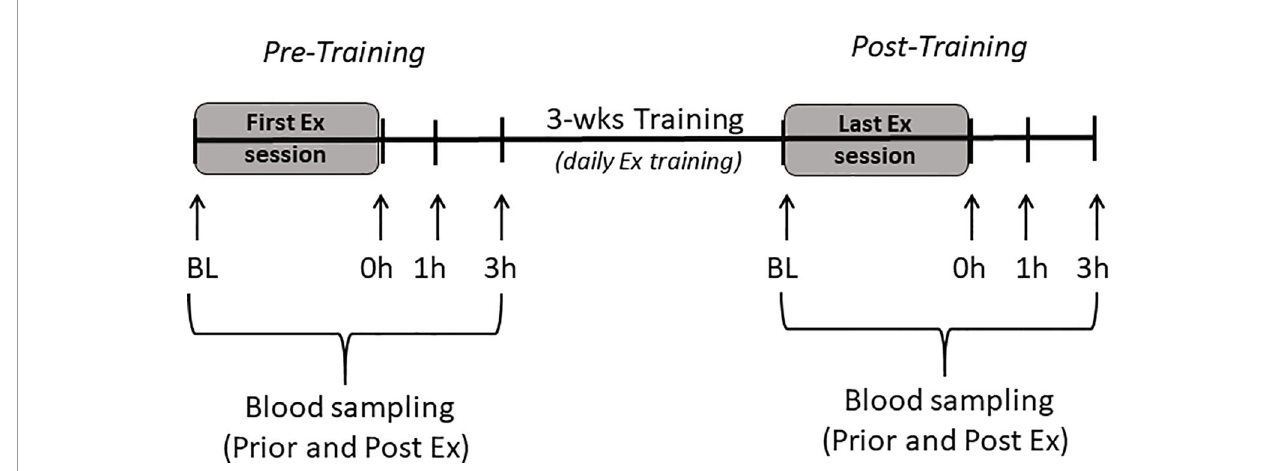
FIGURE 1 | Study scheme. Baseline (BL), immediate (0h), one hour (1h), and 3 hours (3h) after exercise session (Ex).